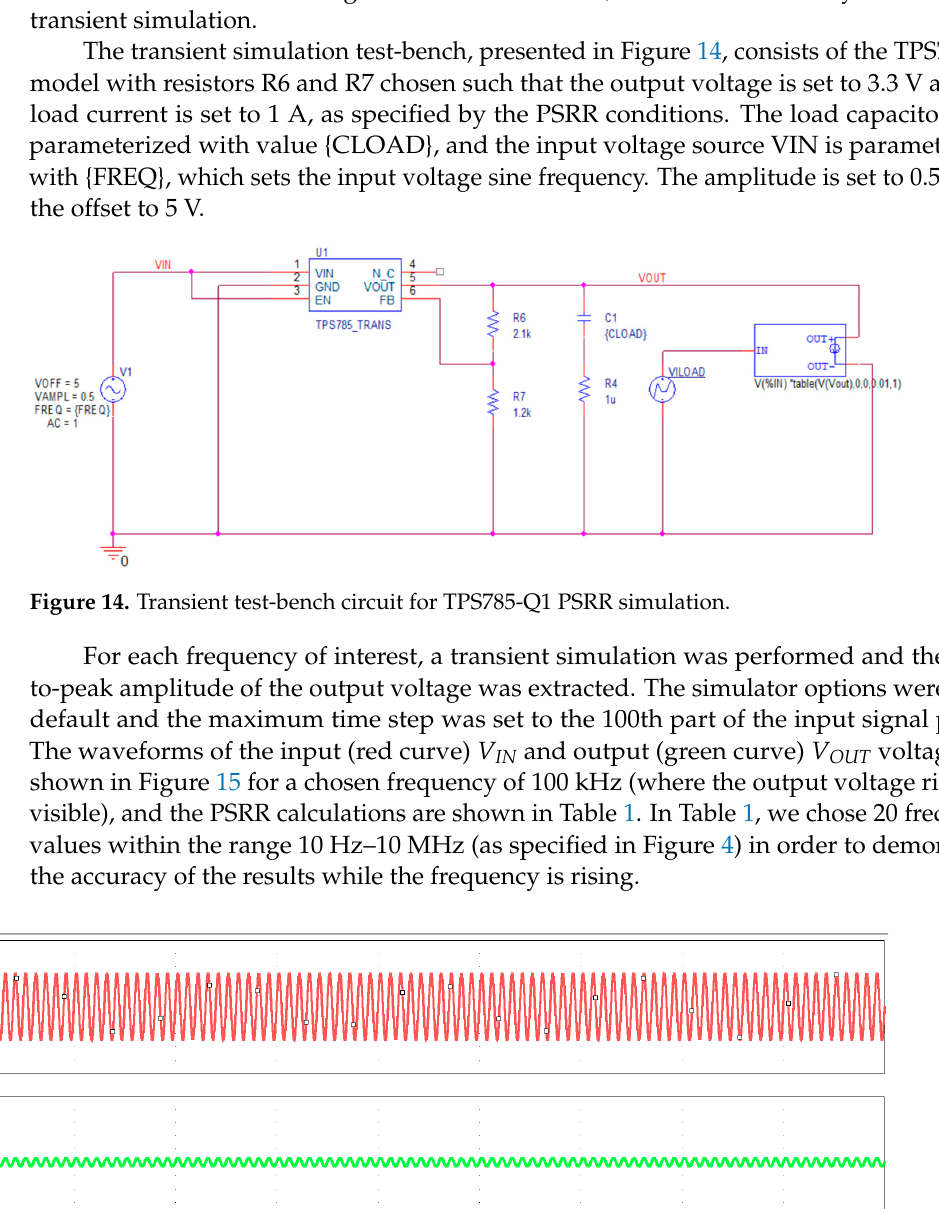
Figure 13. PSpice frequency and V PSRR computation.